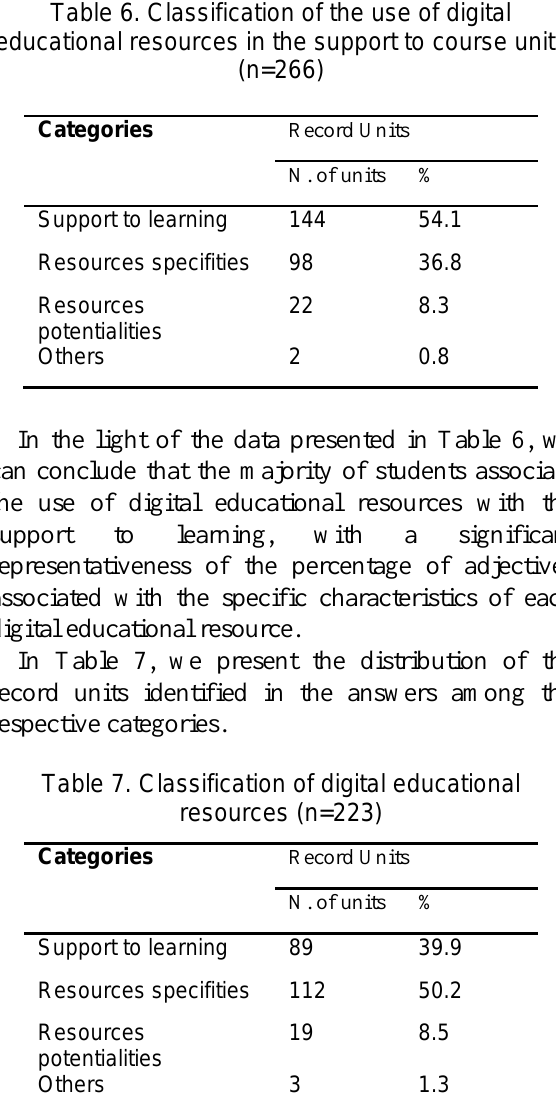
Table 6. Classification of the use of digital